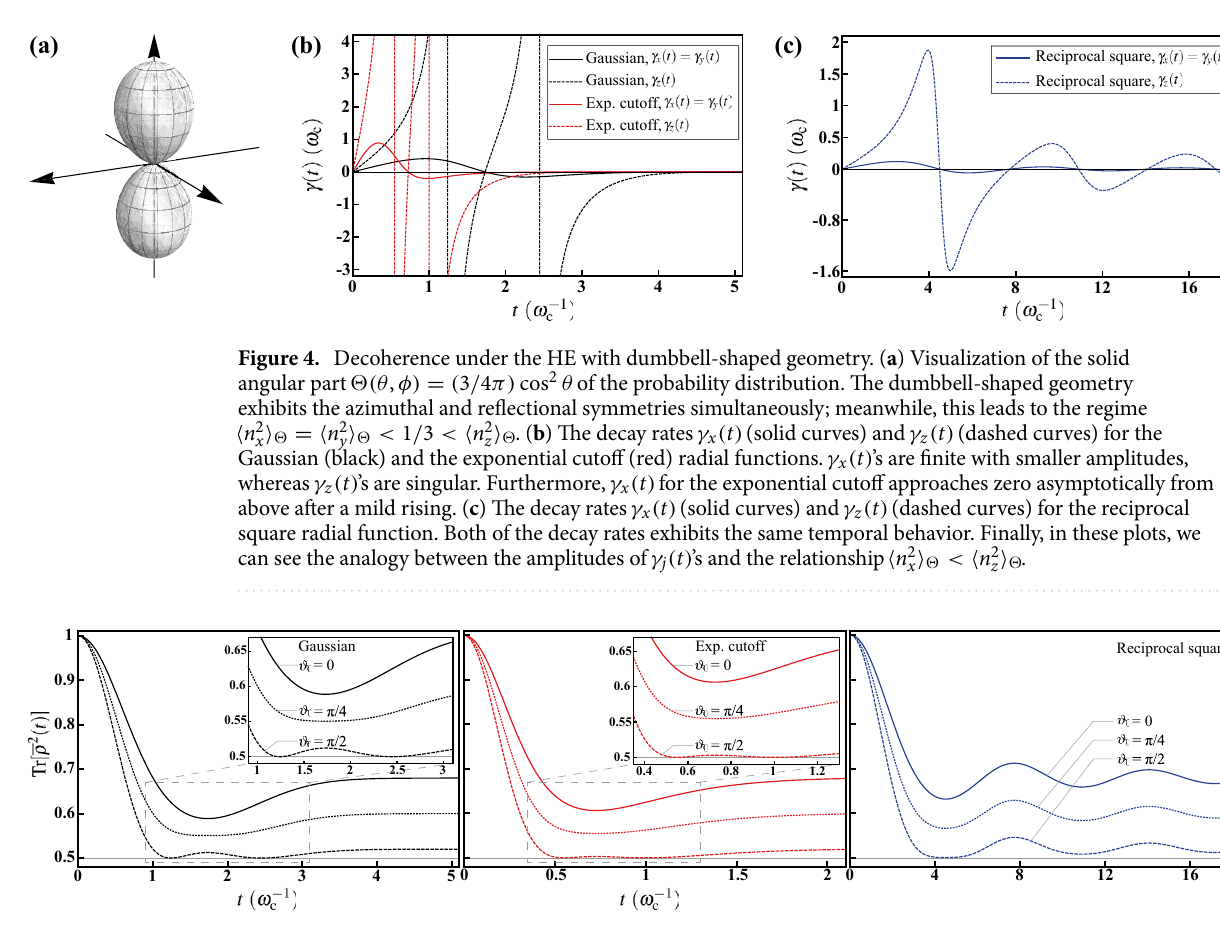
ρ 2 ( t ) ρ 0 ( sin ϑ 0 , 0, cos ϑ 0 ) with ϑ 0 for initial state [ ] � = < n 2 n 2 z (cid:30) � considered here, smaller amplitude of x (cid:30) � (cid:31) (cid:31) π/ 2 , the singular effects of γ z ( t ) are dominant and 0 . While for the case of ϑ 0 = =